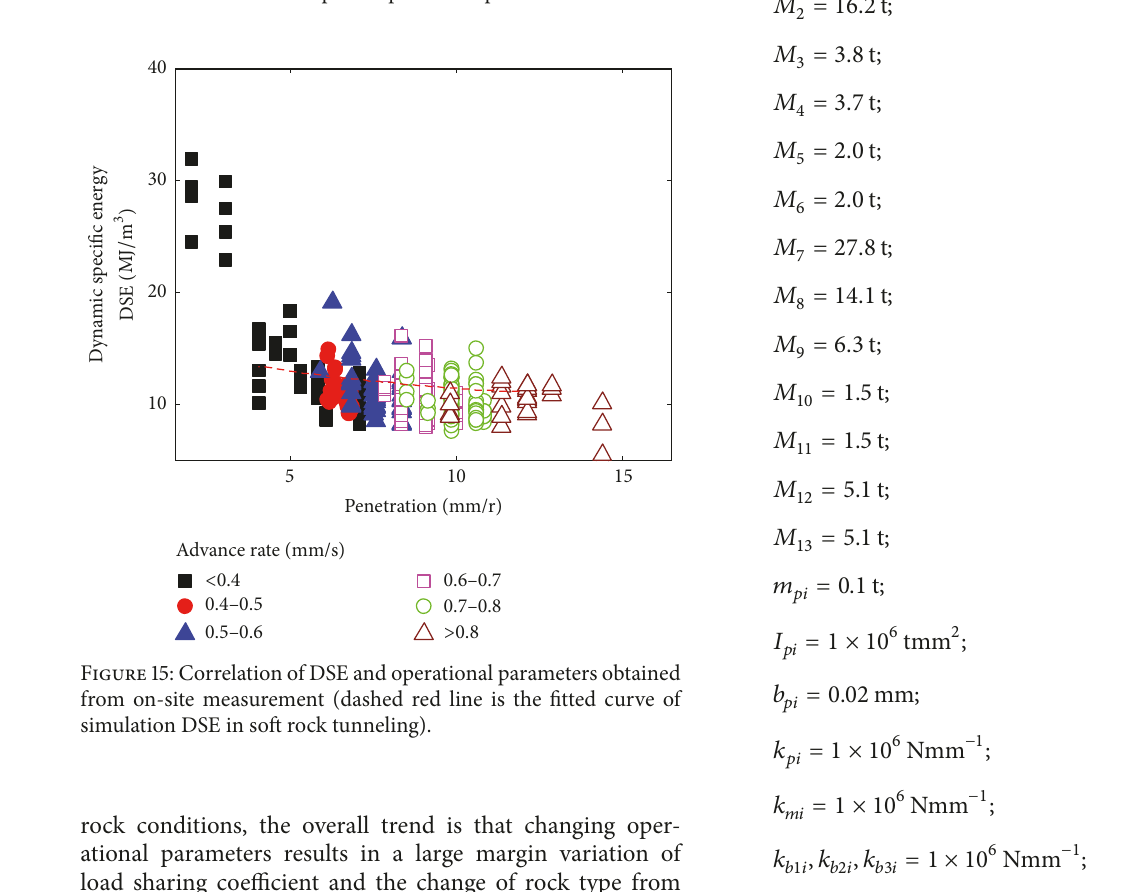
Figure 14: Correlation of acceleration RMS in 𝑍 -direction mea- sured at main beam back tip and operational parameters.